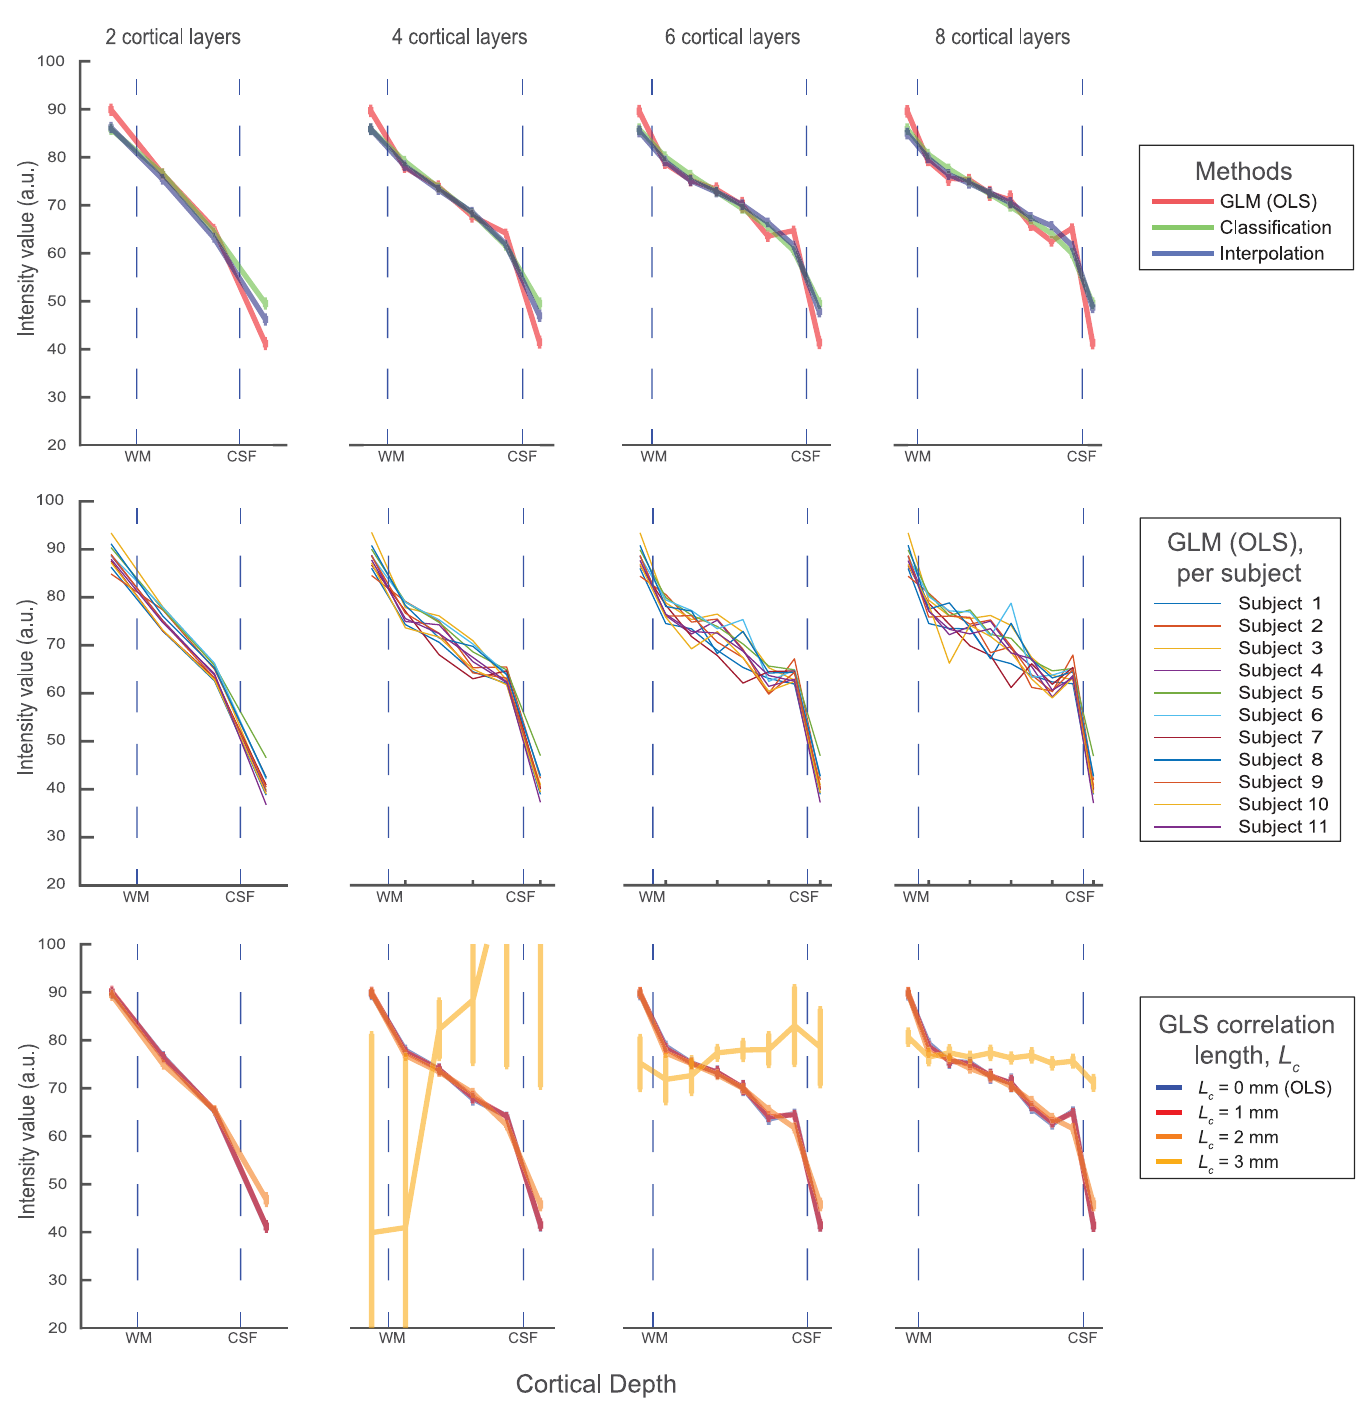
PLOS ONE | https://doi.org/10.1371/journal.pone.0212493 March 27,